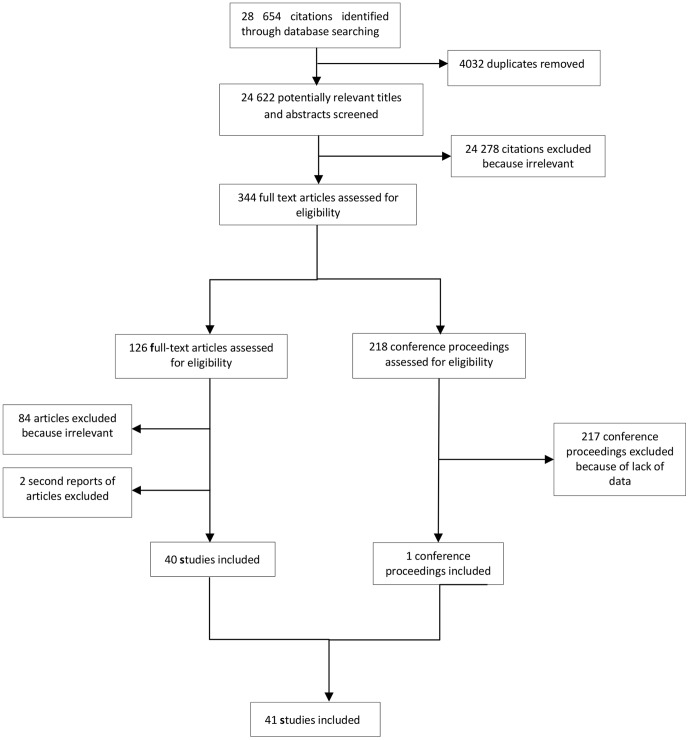
PRISMA Flow diagram.